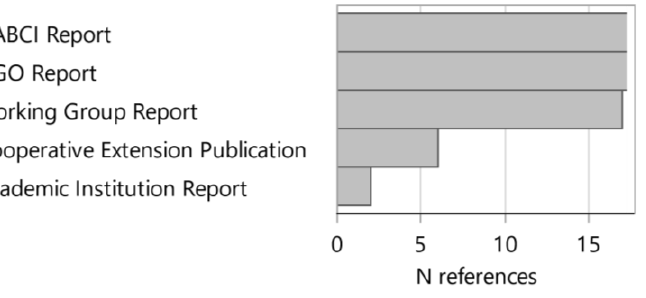
Figure 8. Types of gray literature reports selected for inclusion in Supplementary S5 and/or Sup- plementary S6.